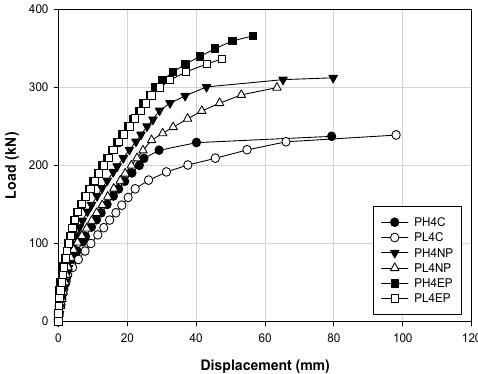
Figure 8. Load–displacement responses for strengthening methods for a concrete strength of 40 MPa for prestressing at 140 and 280 kN.